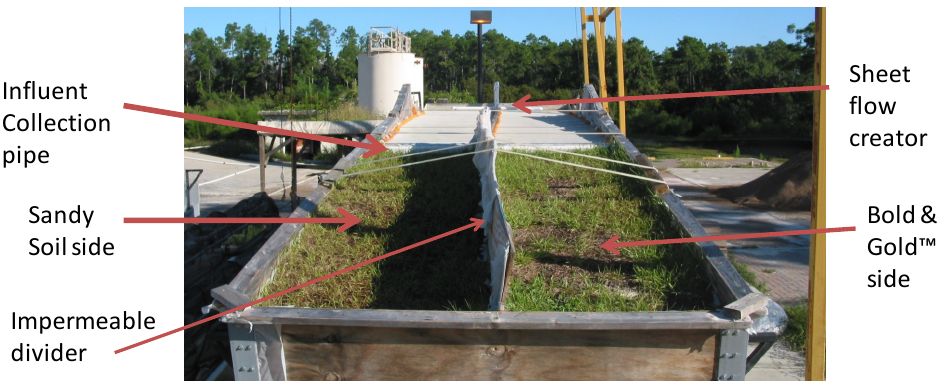
Figure 2. Picture of the fully constructed test